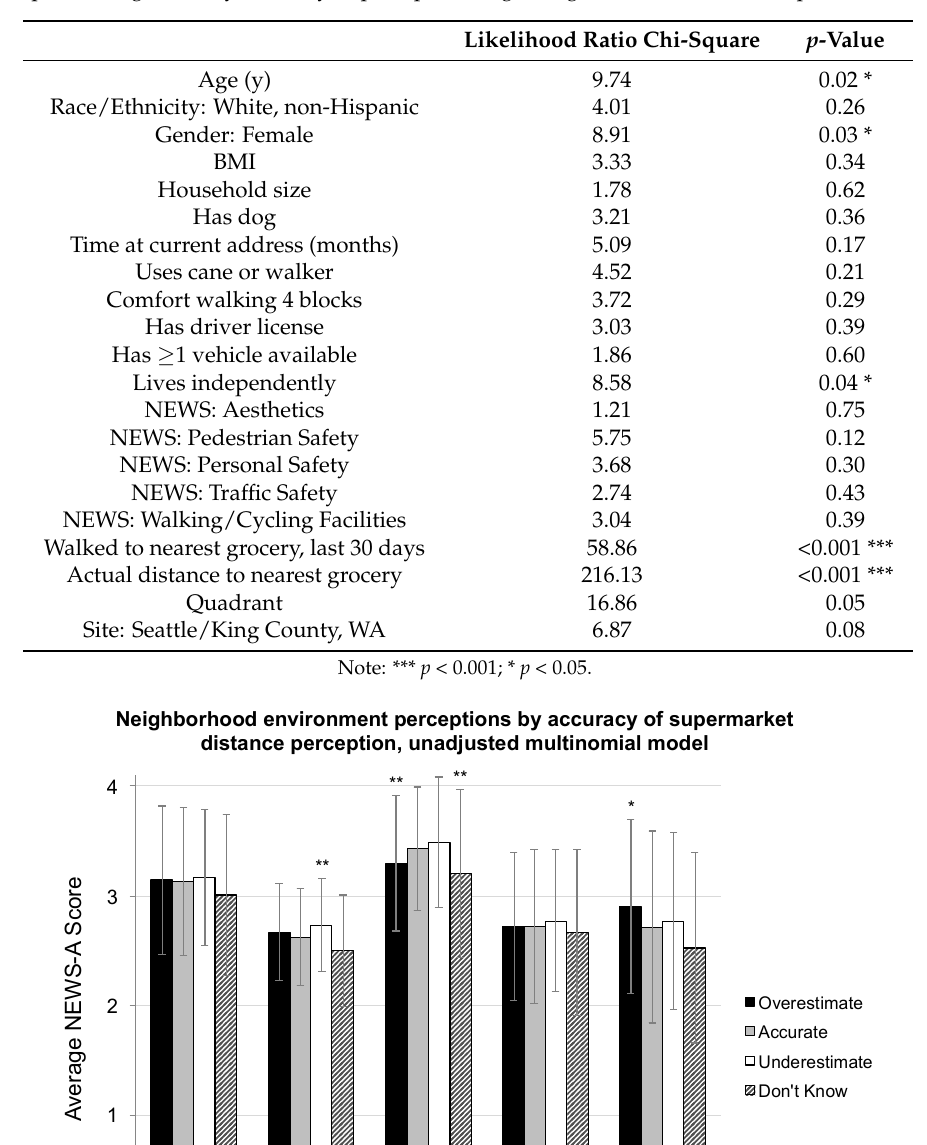
Table 3. Likelihood ratio tests for coefficients in the fully-adjusted multinomial model comparing participants categorized by accuracy of perceptions regarding distance to nearest supermarket.